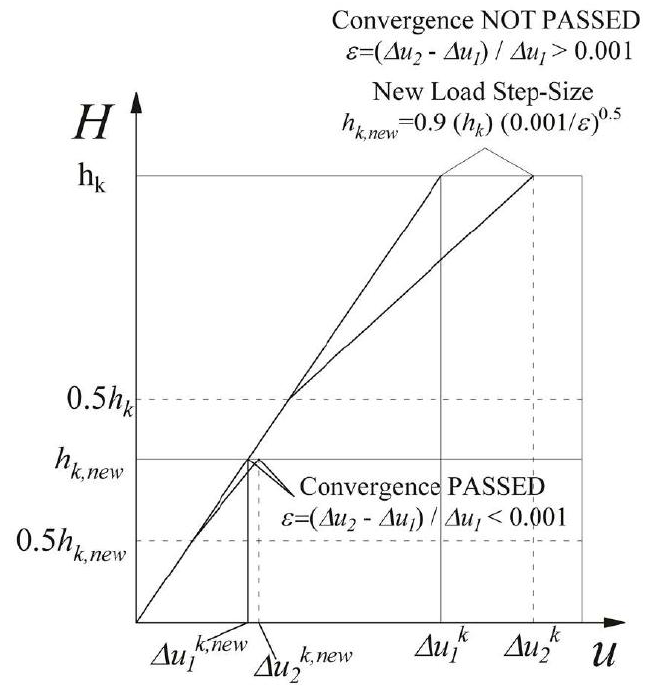
Figure 10. Adaptive step-size control.